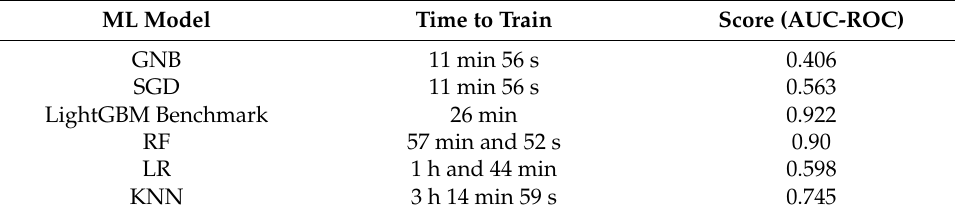
Table 1. Score Comparison of ML Models with Default Parameters (Ember